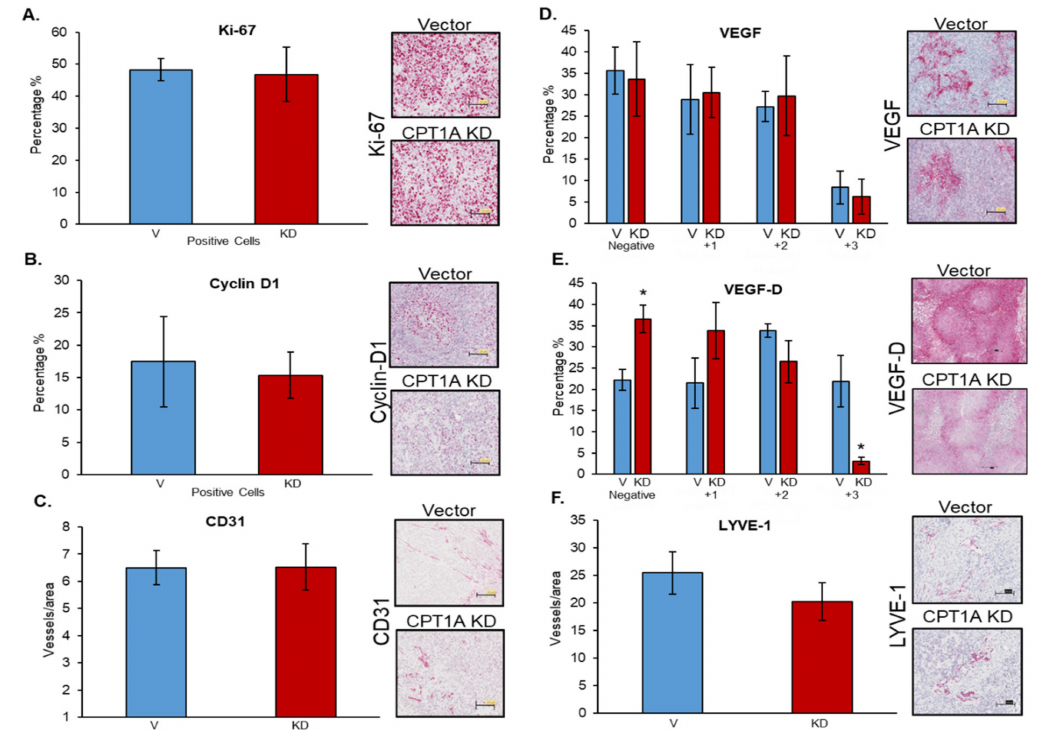
Figure 6. The effects of CPT1A knockdown on proliferation and angiogenesis in 22Rv1 tumors. Tumor tissues from mice bearing vector controls or CPT1A knockdown 22Rv1 tumors were stained to assess various biomarkers by IHC as described in the Methods. Representative images (20 × magnification) and quantified data are presented for ( A ) Ki67 (Vector n = 6, KD n = 7), ( B ) Cyclin D1 (Vector n = 3, KD n = 5, positive and strong positives grouped for analysis), ( C ) CD31 (Vector n = 6, KD n = 7), ( D ) VEGF (Vector n = 5, KD n = 5), ( E ) VEGF-D (Vector n = 4, KD n = 4) (* p < 0.05), and ( F ) LYVE-1 (Vector n = 4, KD n = 7). IHC data are presented as means ± SEM. Scale bar = 100 µ